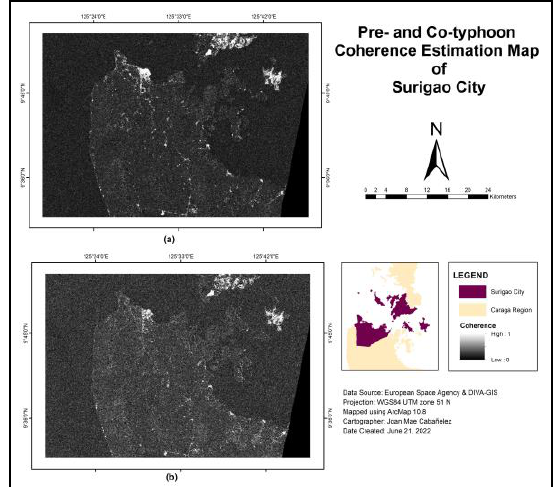
Figure 3 . Pre-typhoon and Co-typhoon Coherence map of Surigao